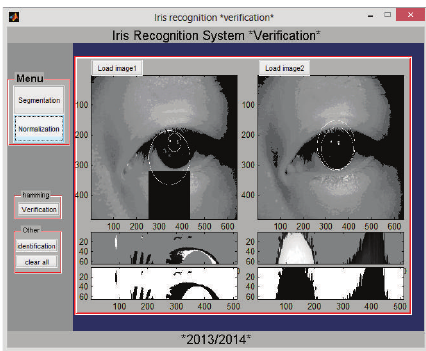
Figure 7: GUI of the verification process in the iris monomodal recognition